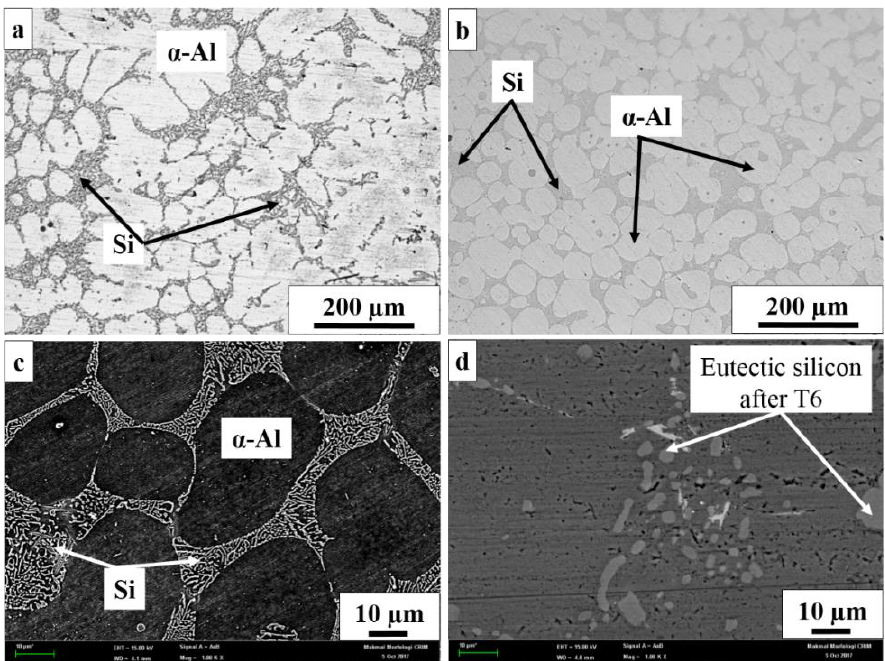
Figure 3. Optical micrographs of the pre-T6 ( a ) as-cast and ( b ) thixoformed samples. SEM micro- graph of the thixoformed ( c , d ) post-T6 Si particles of thixoformed samples